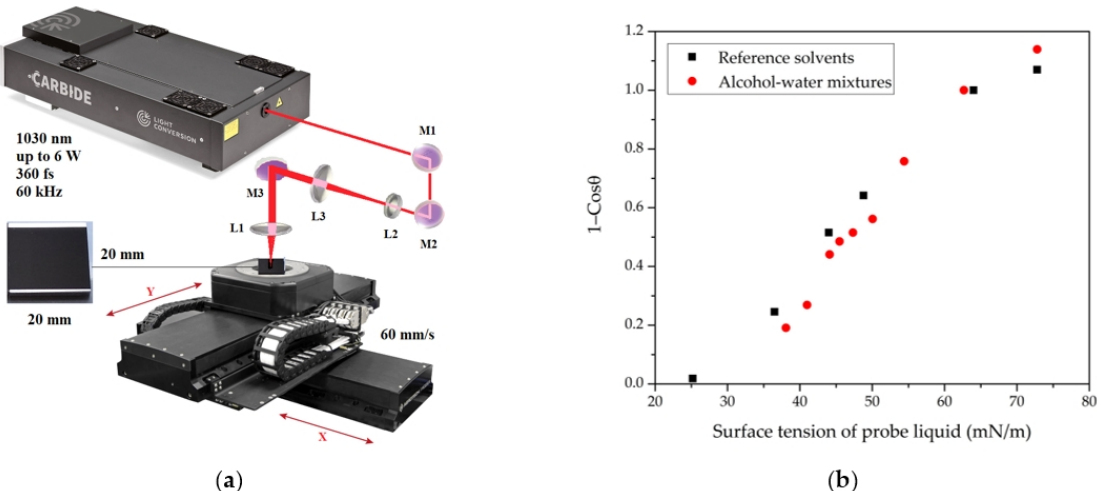
Figure 1. ( a ) Laser processing setup: M1, M2 and M3—Deflecting mirrors, L1—Focusing lens, L2 and L3—Plano-concave and plano-convex lenses of the expanding telescope. ( b ) Comparison of contact angles of reference probe liquids and water–alcohol mixtures on a POTS-treated fAl